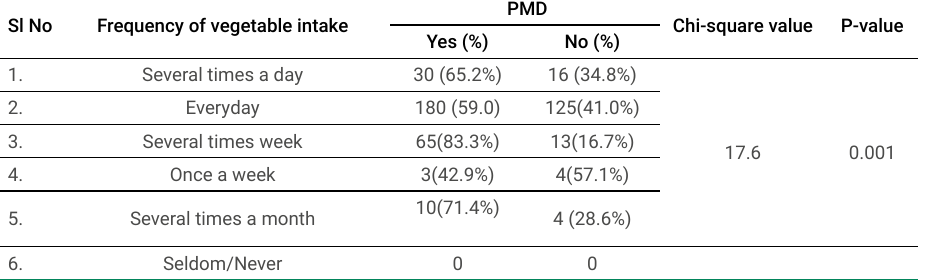
Table 6. Distribution of subjects according to socioeconomic status and PMD Per capita monthly income